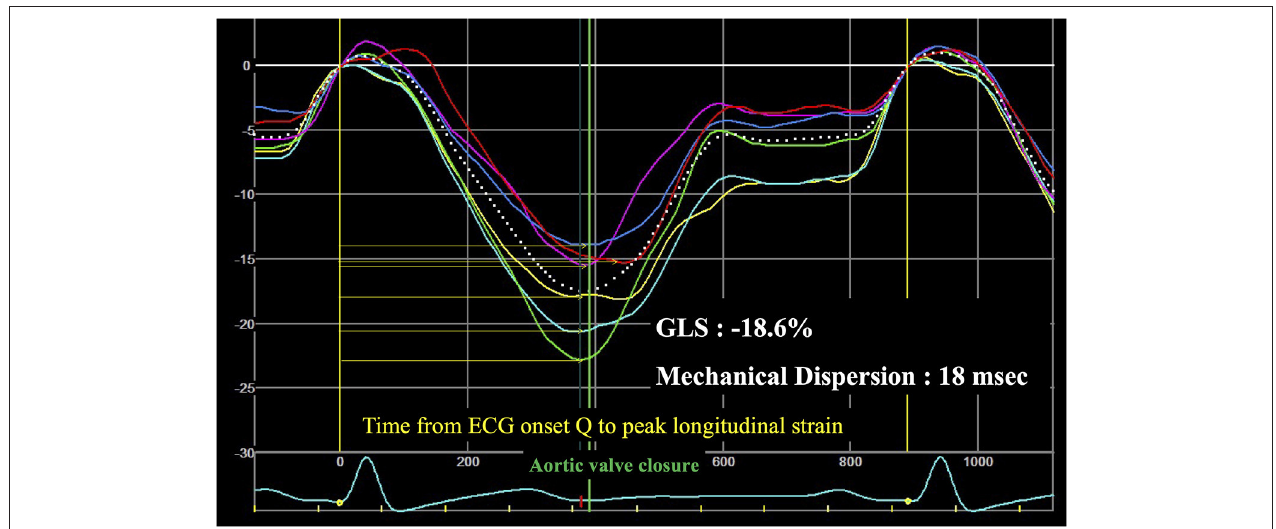
FIGURE 1 | Example of speckle-tracking strain analysis of left ventricular mechanical dispersion. GLS, global longitudinal strain; Mechanical Dispersion, assessed by the standard deviation of the 18 segments (for the clarity of the figure only 6 segments are shown).